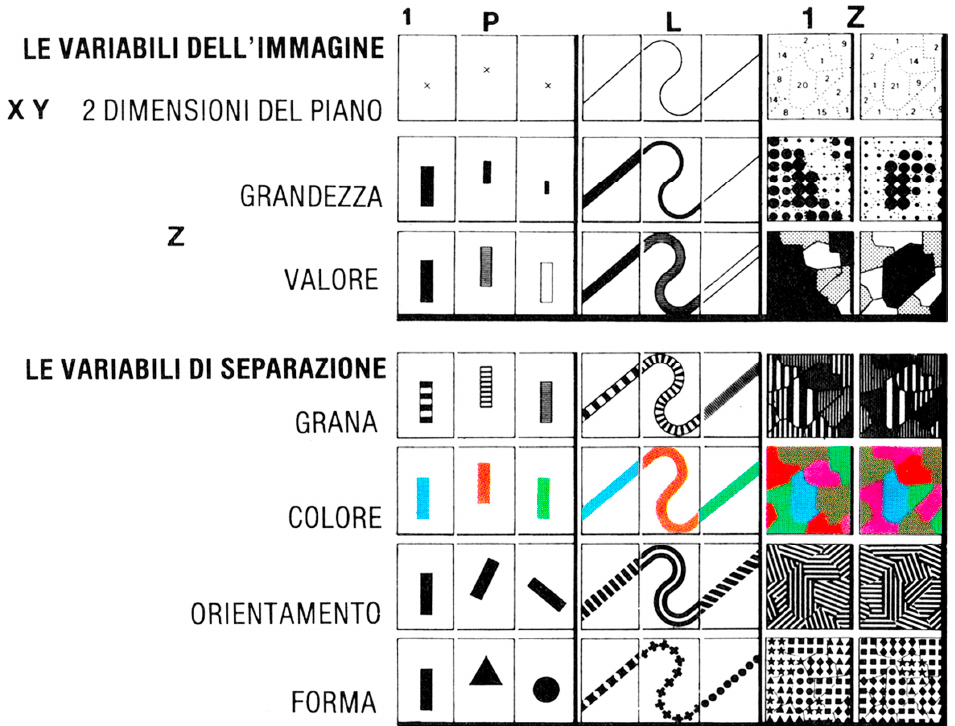
Figure 4. Diagram of the eight visual variables in the plan [13] (p. 187).